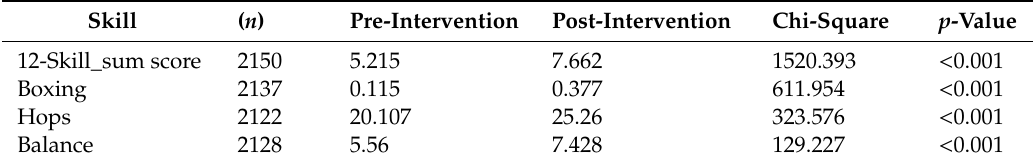
Table 5. Wald test for SCALE-UP All 4 Kids ©